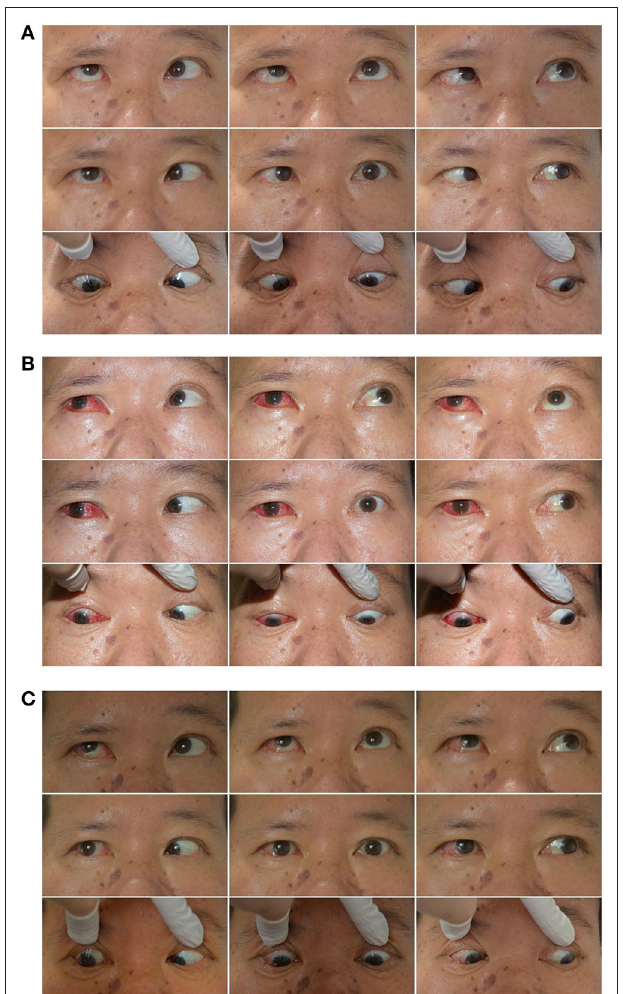
FIGURE 4 | Typical case 2 showed the patient with abduction = − 2 on the last visit. A 55-year-old male whose right eye deviated inward for one year after resection of a trigeminal neuroma. He was diagnosed as complete traumatic abducens nerve palsy and received a medial rectus recession of 8mm and lateral resection of 11mm in his right eye while under general anesthesia. The FDT performed during surgery was positive. (A) The patient’s 9-gaze eye position photo is shown preoperatively with right eye esotropia 40PD (RET = 40PD), abduction-4, adduction normal. (B) 1 day postoperatively with right eye exotropia 20PD (RXT = 20 PD), abduction-1, adduction-4. (C) 2 months postoperatively with right eye exotropia 8PD (RXT = 8 PD), abduction-2,